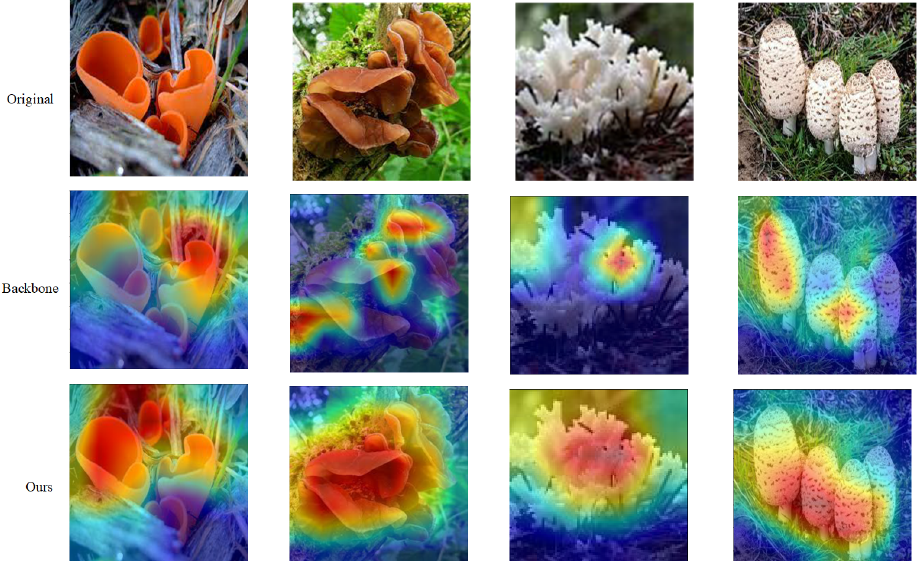
Figure 11. The thermodynamic diagrams of backbone model and ours.